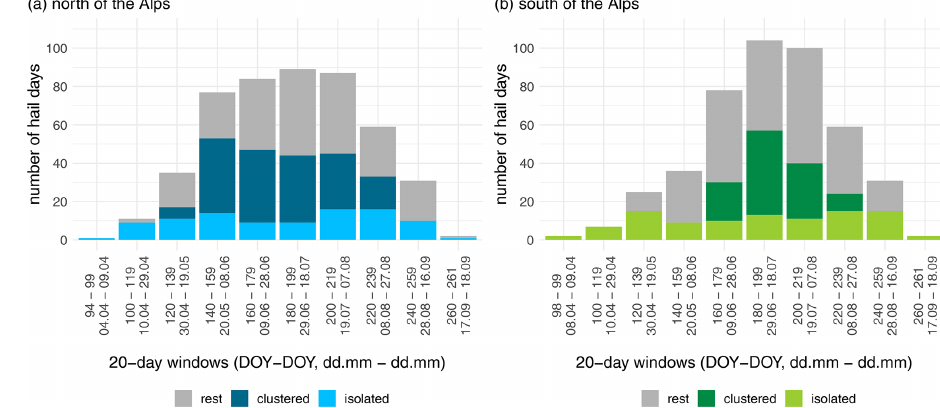
Figure 3. The total number of hail days (gray bars), the number of clustered hail days (darker color), and the number of isolated hail days (lighter color) for 20d windows across the hail season for hail events north of the Alps ( a , blue colors) and south of the Alps ( b , green colors) between 2002–2019. The numbers on the x axis indicate the day of the year and the equivalent dates of a common year. In this graph, the isolated hail days are also shown for the period outside of which clustered hail days are